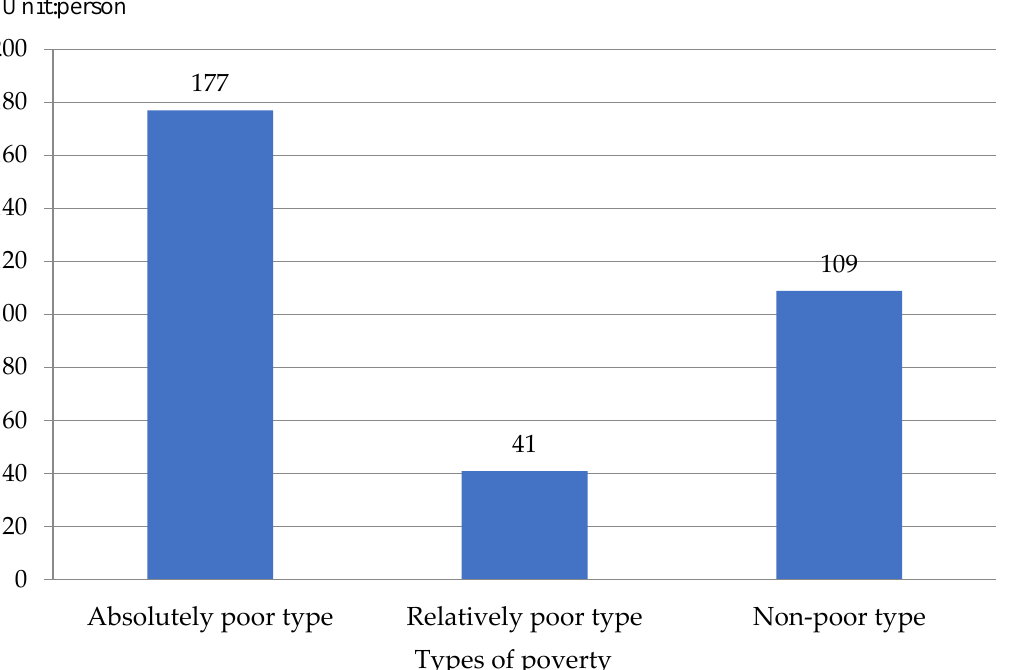
Table 3. Ordinal logistic regression results of the difference in livelihood risks faced by different types of poverty-stricken farmers.